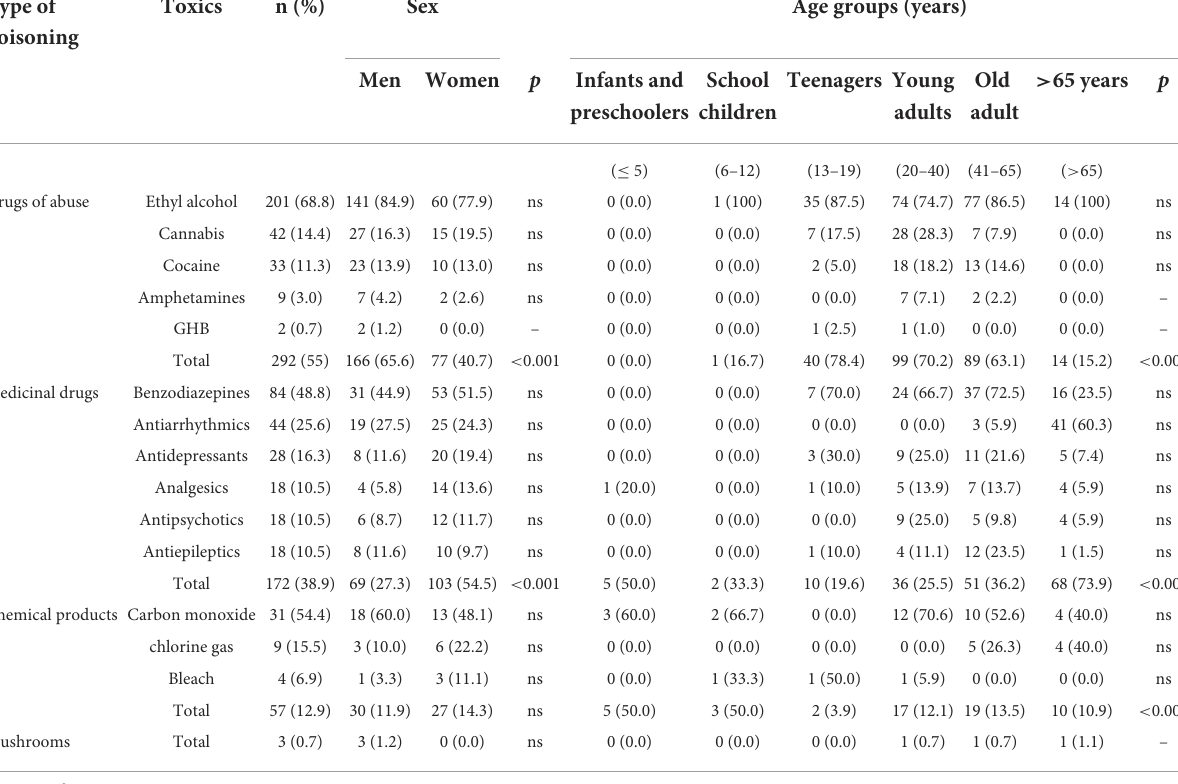
TABLE 1 Clinical and sociodemographic profile.